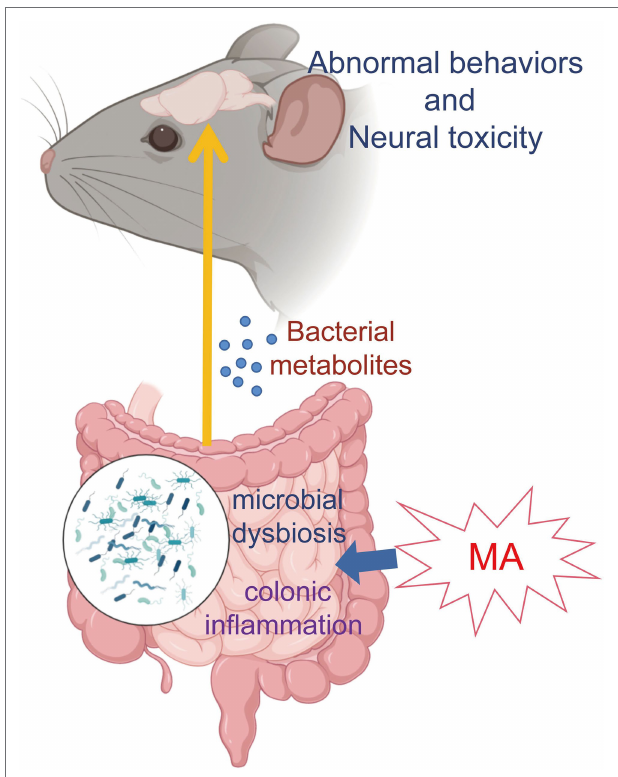
FIGURE 5 | Mechanism map. MA disordered the gut homeostasis via disturbing microbiome and stimulating inflammation. Then, microbial metabolites entered the systemic circulation through the damaged intestinal barrier, which was involved in MA-induced neurotoxicity and behavioral